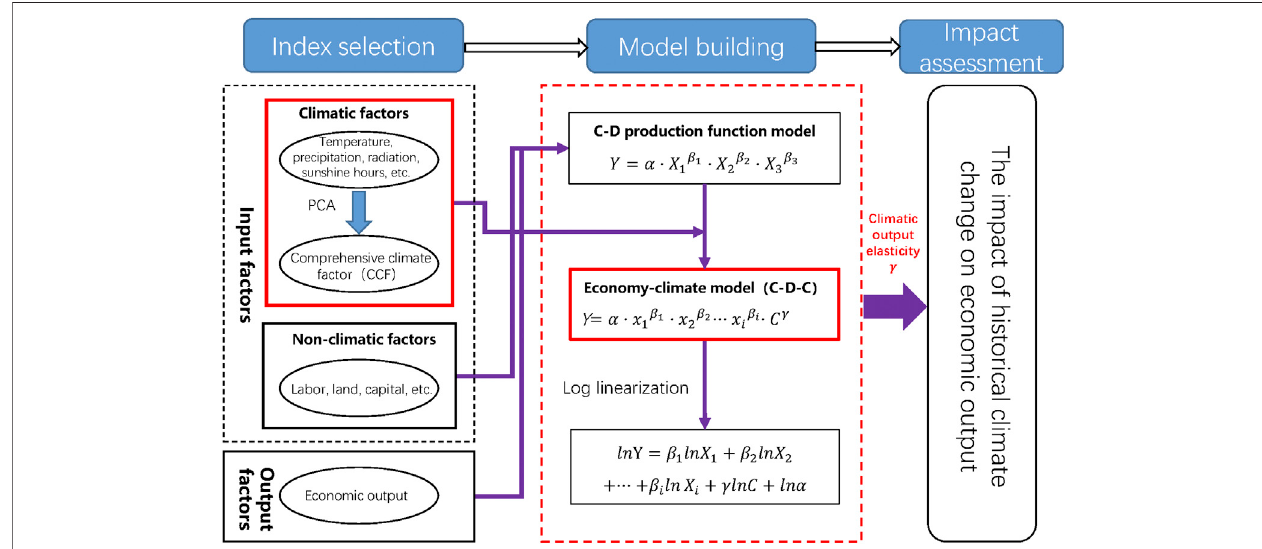
FIGURE 1 | Schematic diagram of the economy-climate (C-D-C) model. Y is an economic output, x i is an economic factor ( i ≥ 3), β i is an output elasticity corresponding to the economic factor, C is a climatic factor, c is an output elasticity corresponding to climatic factor (called “ climatic output elasticity ” ), α represents the sum of the in fl uence of factors other than economic and climatic factors.